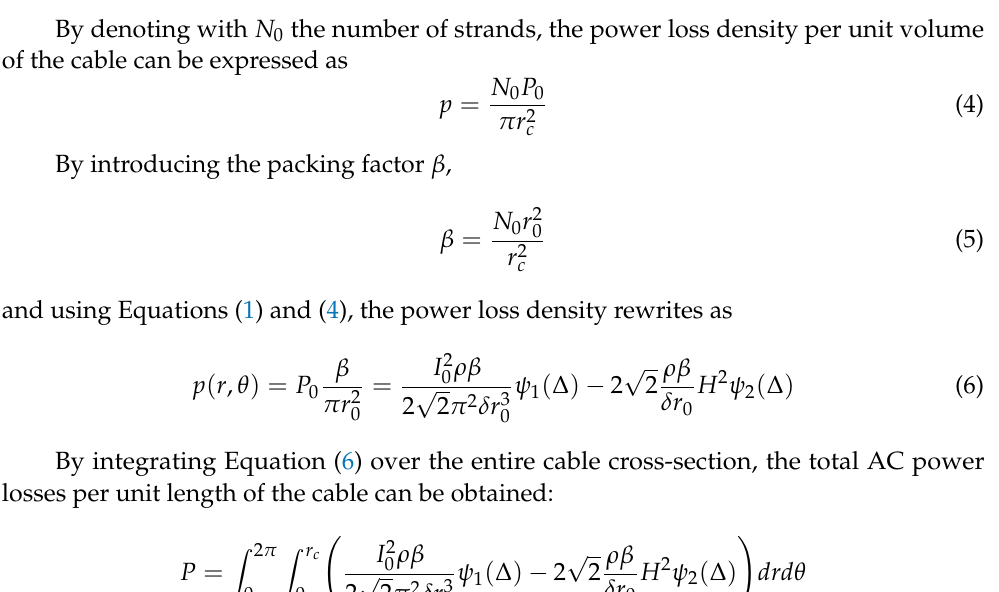
Figure 2. Multi-stranded cable